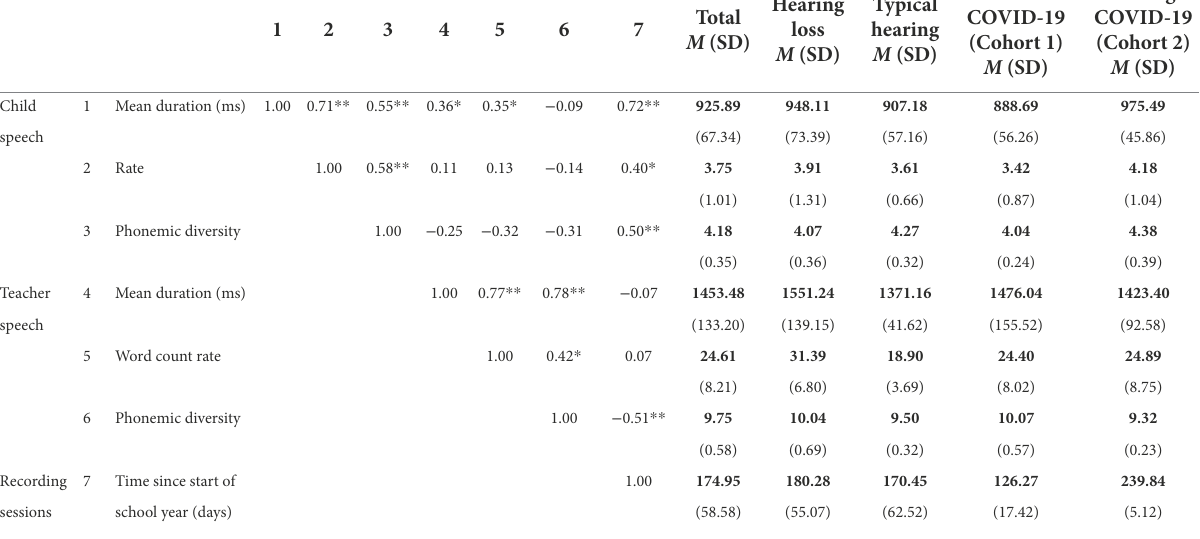
TABLE 2 Correlations between and child and teacher language